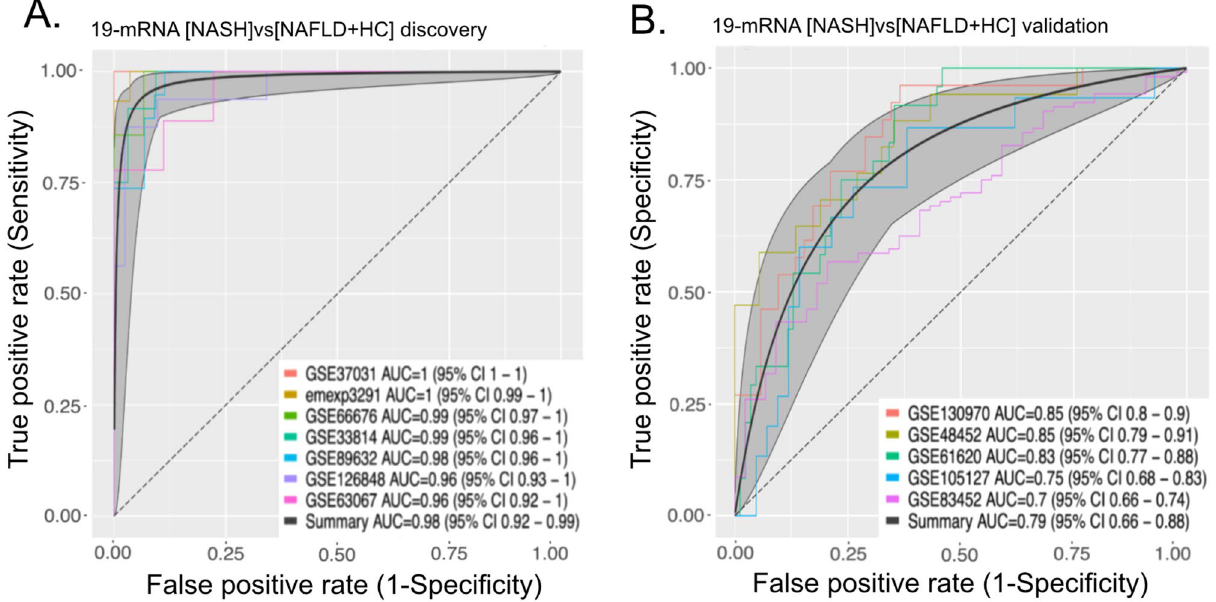
Figure 3. A parsimonious set of 19 genes retains the full performance of [NASH]vs[NAFLD + HC] signature. ( A ) Performance of 19-gene signature in discovery studies. ( B) Performance of 19-gene signature in validation